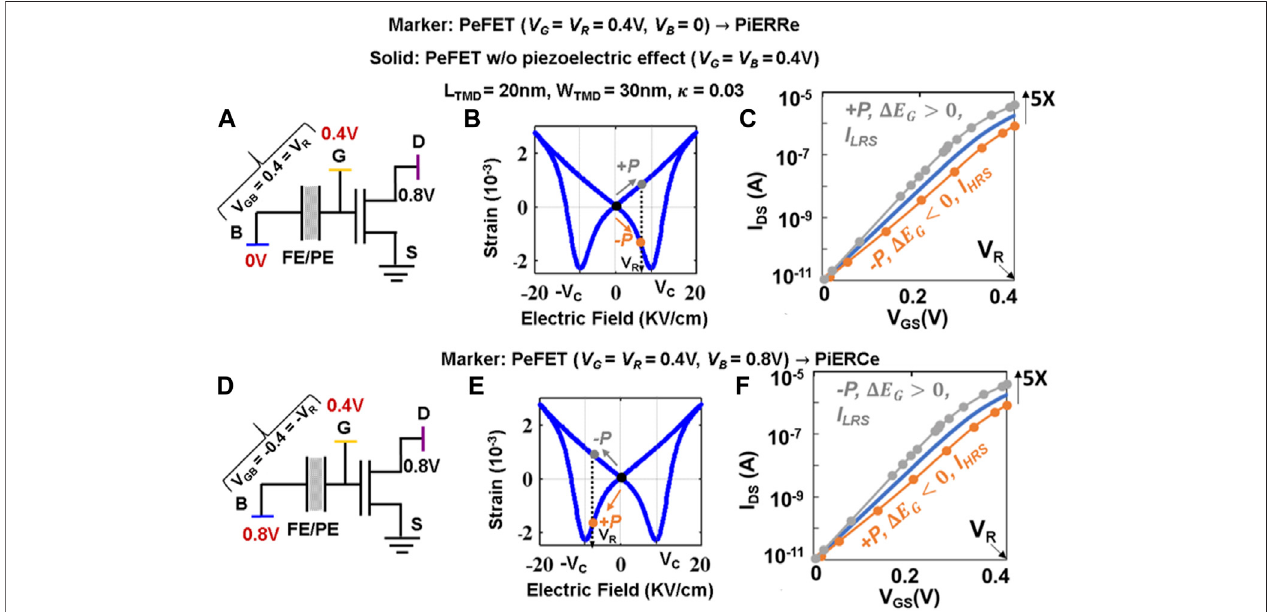
FIGURE5|(A) SchematicrepresentationofPeFETfor V G =0.4 V, V B =0 V, V GB =0.4 V > 0,or PiERRe mode. (B) Strain – electric fi eldresponsefor V GB = V R > 0. (C) Devicecharacteristicsfor V GB > 0. (D) SchematicrepresentationofPeFETfor V G =0.4 V, V B =0.8 V, V GB = − 0.4 V < 0,or PiERCe mode. (E) Strain – electric fi eldresponse for V GB = − V R < 0. (F) Device characteristics for V GB <